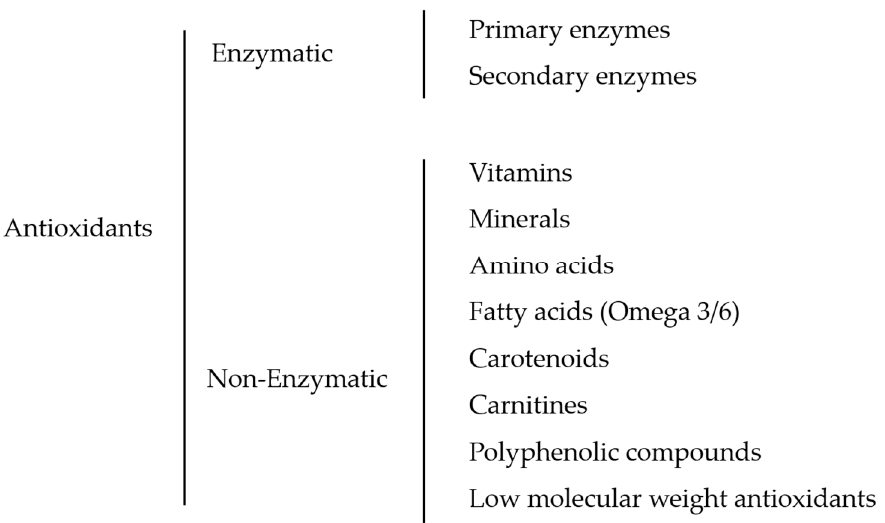
Figure 2. Classification of the reviewed fish sperm antioxidants.